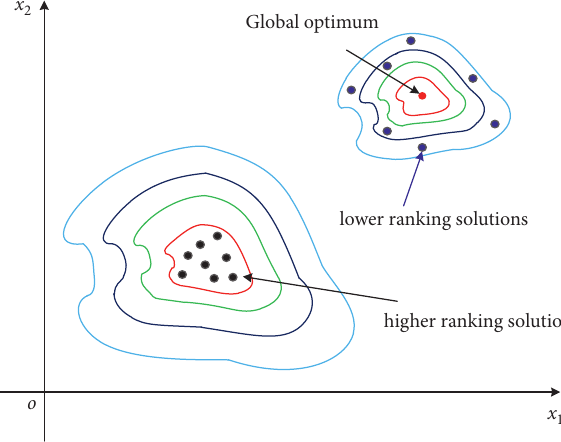
Figure 3: The population distribution for a typical multimodal